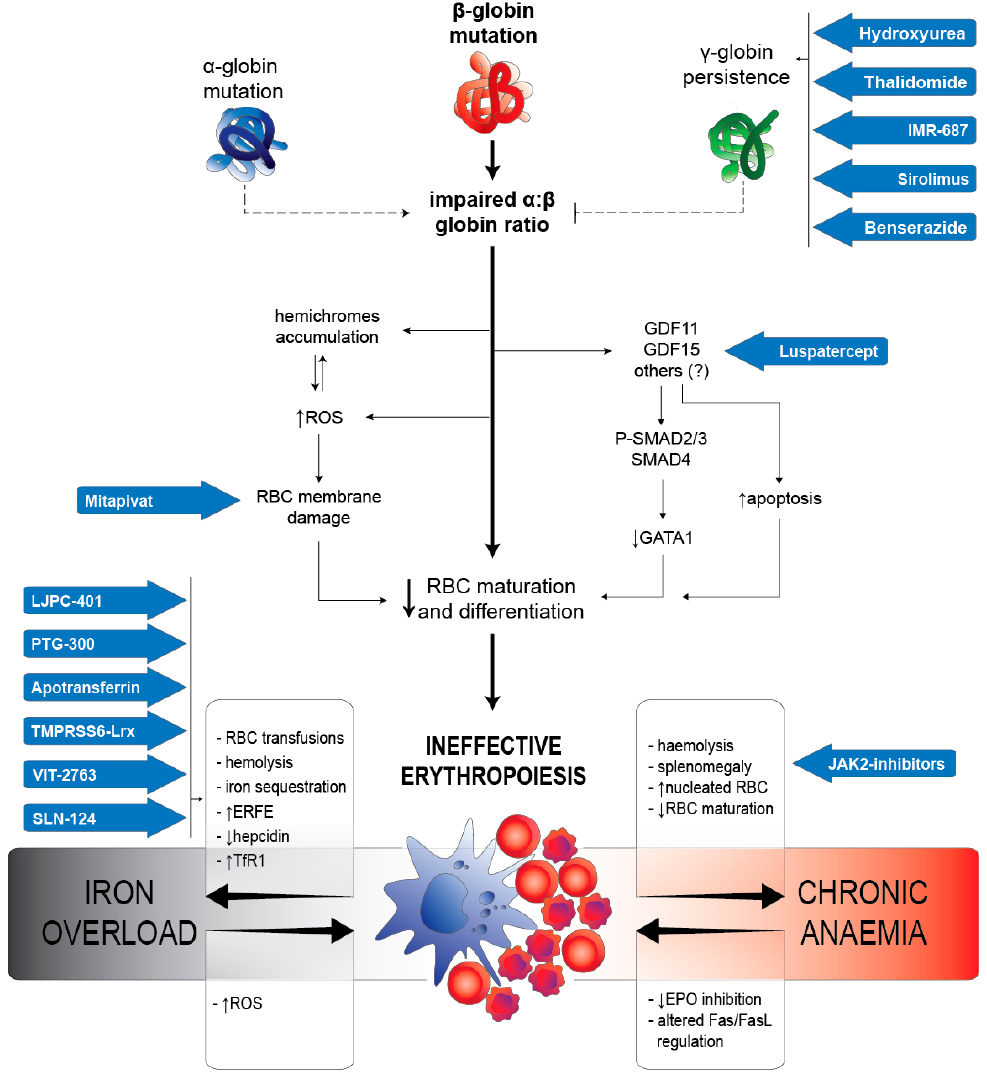
Figure 1. Schematic representation of mechanisms of ineffective erythropoiesis (IE) in β -thalassaemia. Blue arrows identify potential new treatments under investigation for this condition.